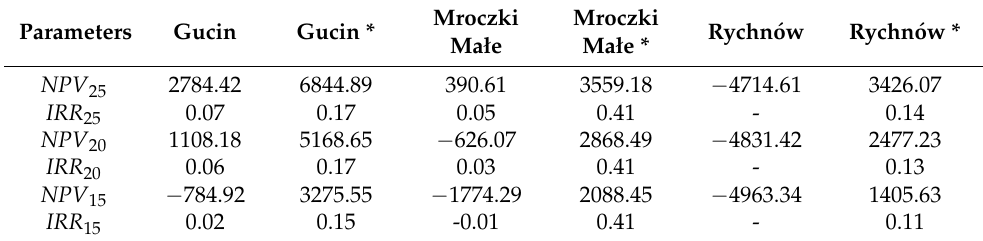
Table 13. NPV and IRR values (in thousand